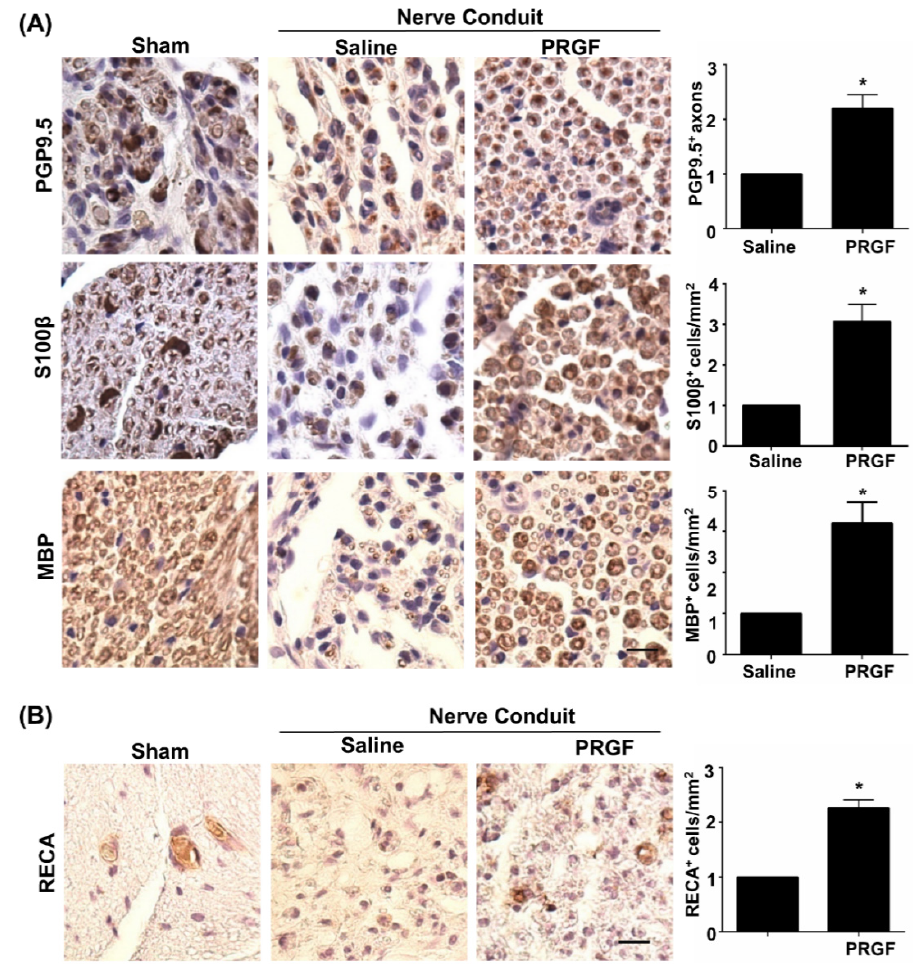
Figure 4. Improvements of nerve regeneration, remyelination, and angiogenesis by PRGF after sciatic nerve injury. ( A ) The IHC staining for PGP9.5, S100 β , and MBP demonstrated increases in axon regrowth, SCs numbers, and remyelination after treatment with PRGF for 6 weeks. ( B ) An increase in angiogenesis and vascular formation was observed by IHC staining of rat endothelial cell antigen (RECA). Scale bar = 20 µ m. N = 3. Significance was assessed by paired t -test. Data are presented as the mean ± SEM. * p < 0.05 versus the saline group.